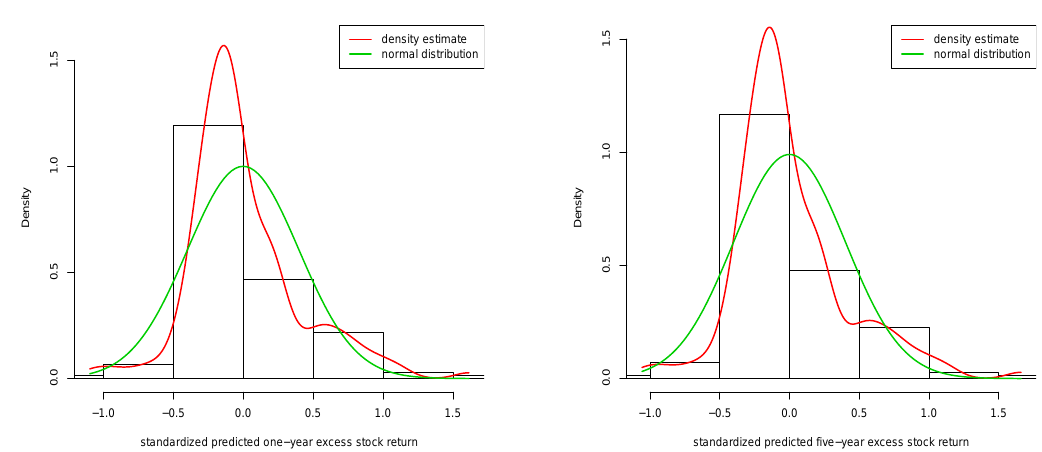
Figure 2. Standardized predicted stock returns in excess of the inflation benchmark (based on the model using earnings-by-price as covariate for mean-prediction; double benchmarking). Histogram, kernel density estimate (red), and fitted normal distribution (green). Left : one-year horizon. Right : five-year horizon. Period: 1872–2019. Data: annual S&P